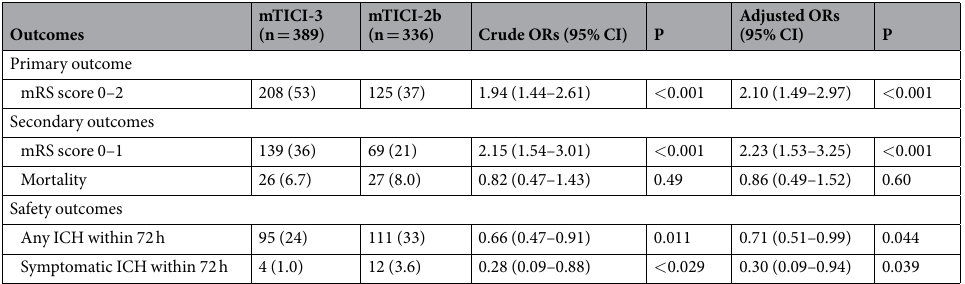
Table 2. Outcomes at 90 days. Data are presented as n (%). CI indicates confidence interval; ICH, intracranial hemorrhage; mRS, modified Rankin Scale; mTICI, modified thrombolysis in cerebral infarction; OR, odds ratio. Adjusted variables are as follows: age, sex, National Institutes of Health Stroke Scale score, Alberta Stroke Program Early Computerized Tomography Score, target occlusion location, intravenous alteplase administration, and time from onset to